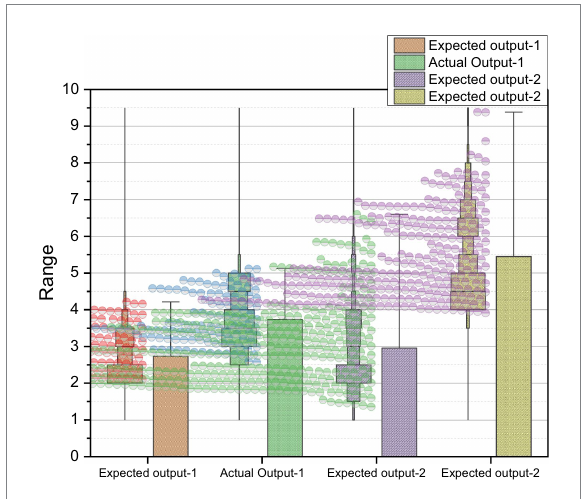
FIGURE 6 Comparison of the actual and expected output of training and test samples.